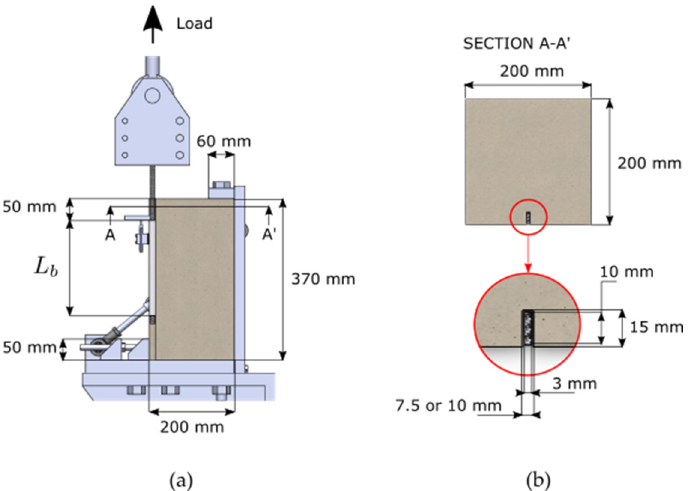
Figure 1. ( a ) lateral view of the setup and ( b ) detailed view of the groove dimensions and CFRP strip position.